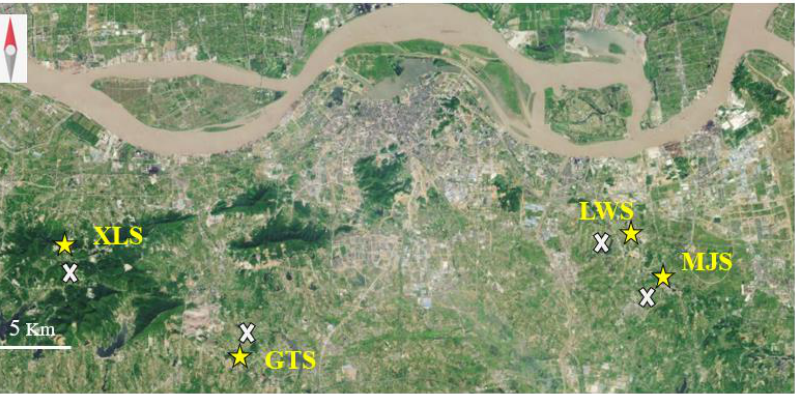
Figure 1. Map of survey site pairs in the areas around Zhenjiang City on the Yangtze River, Jiangsu Province. Yellow stars indicate mine sites and white crosses indicate reference sites.